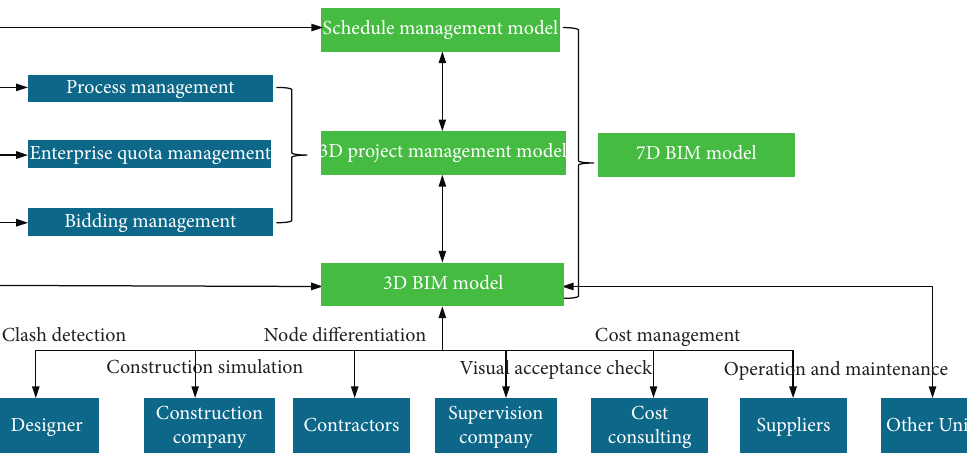
Figure 2: General framework of the 7D BIM.